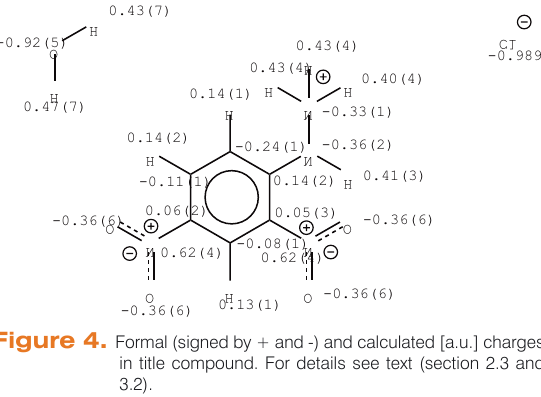
Figure 4. Formal (signed by + and -) and calculated [a.u.] charges in title compound. For details see text (section 2.3 and 3.2).